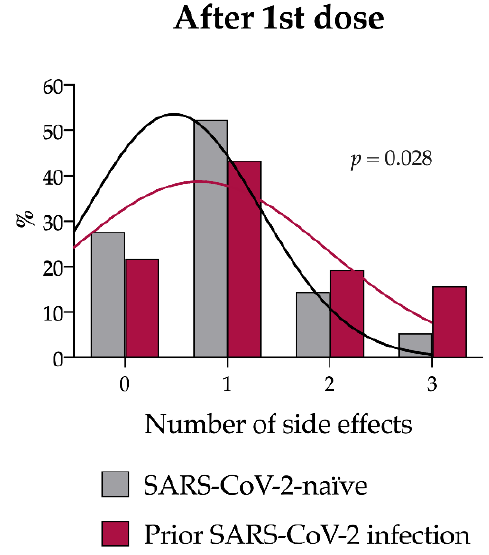
Figure 2. Number of solicited side effects after the first vaccine dose in the study population after case–control matching. Number of side effects reported by SARS-CoV-2 naïve (gray) and previously infected (magenta). A right shift in the distribution of the number of side effects was observed in SARS-CoV-2 naïve subjects ( p = 0.028 by Chi-squared test).